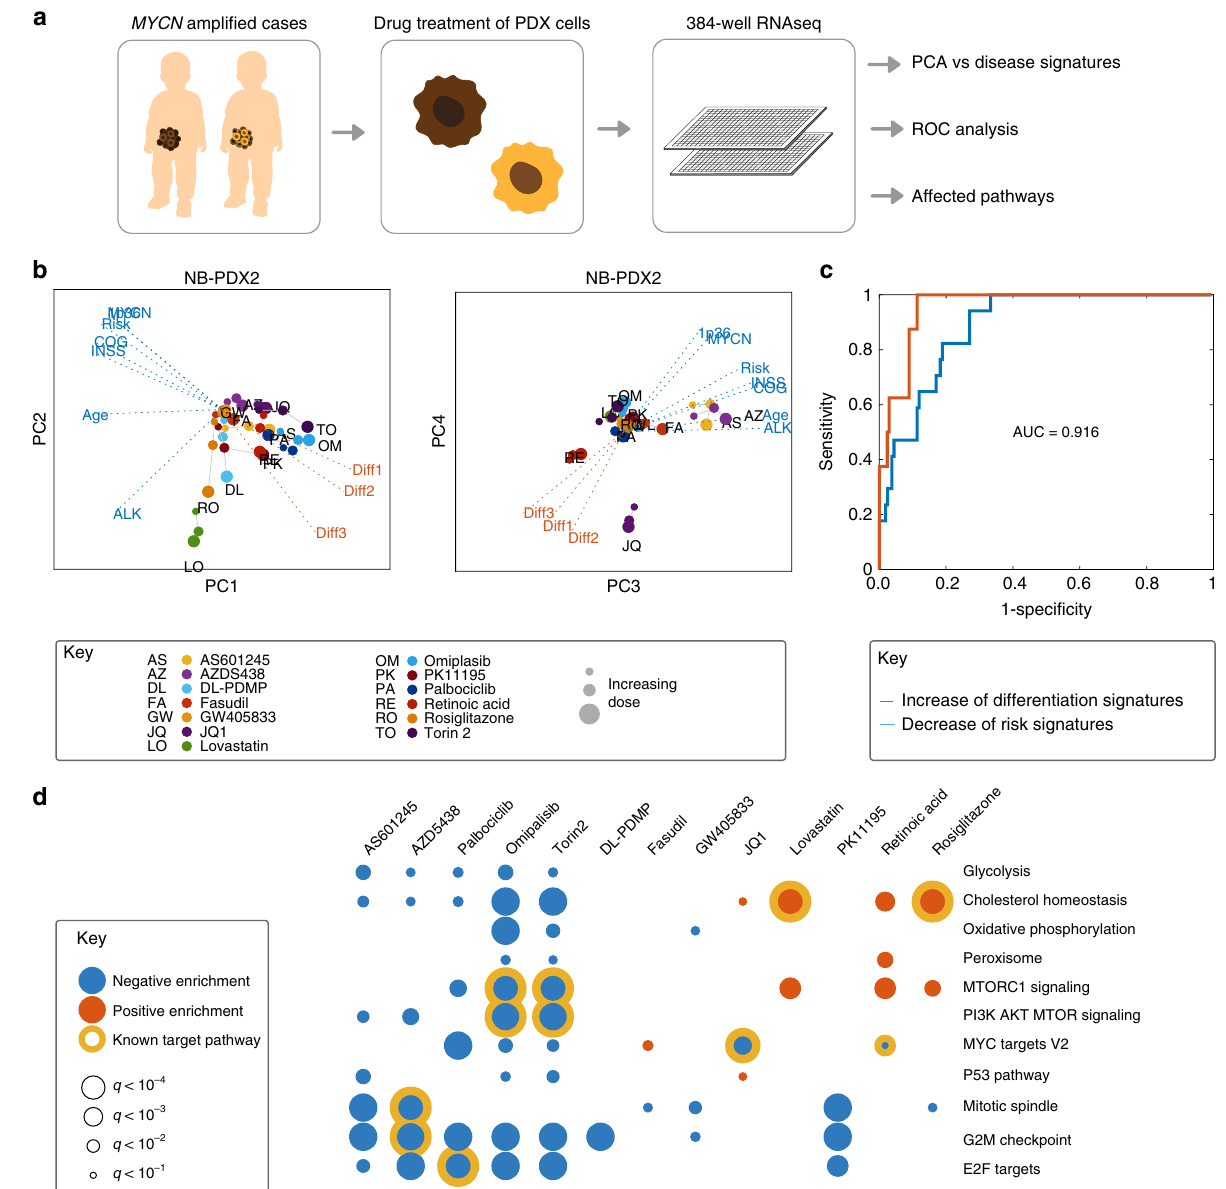
Fig. 4 RNA pro fi ling con fi rmed modulation of neuroblastoma risk signatures. a Experiment concept. b Principal component analysis of results for patient 1 (NB-PDX2). Note similar directions of PI3K and MTOR inhibitors omipalisib (OM) and torin-2 (TO) along PC1, and differentiation-inducing agents retinoic acid and JQ1 along PC 4. See also Supplementary Fig. 3. c ROC curve analysing the predictive power of TargetTranslator, de fi ned as the ability to predict (from the public data sources) whether a particular gene signature will decrease (blue) or increase (red) after drug treatment; showing average for 10 risk signatures and all tested drugs, overall area under the curve correctness of 0.916. d Gene Set Enrichment Analysis (GSEA) of drug-induced changes, showing suppressed (blue) and induced (red) pathways. Yellow circles mark the known action of each corresponding